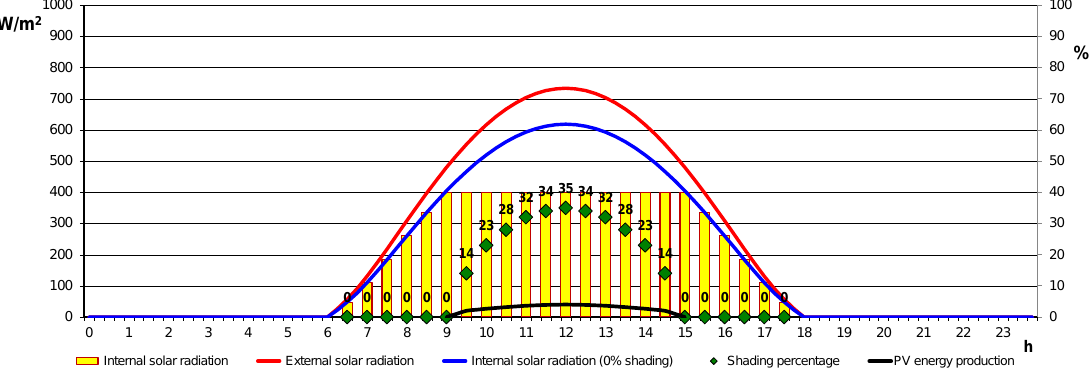
Figure 11. Daily trend of shading percentages so that the internal solar radiation is lower than or equal to the set limit on March 21.